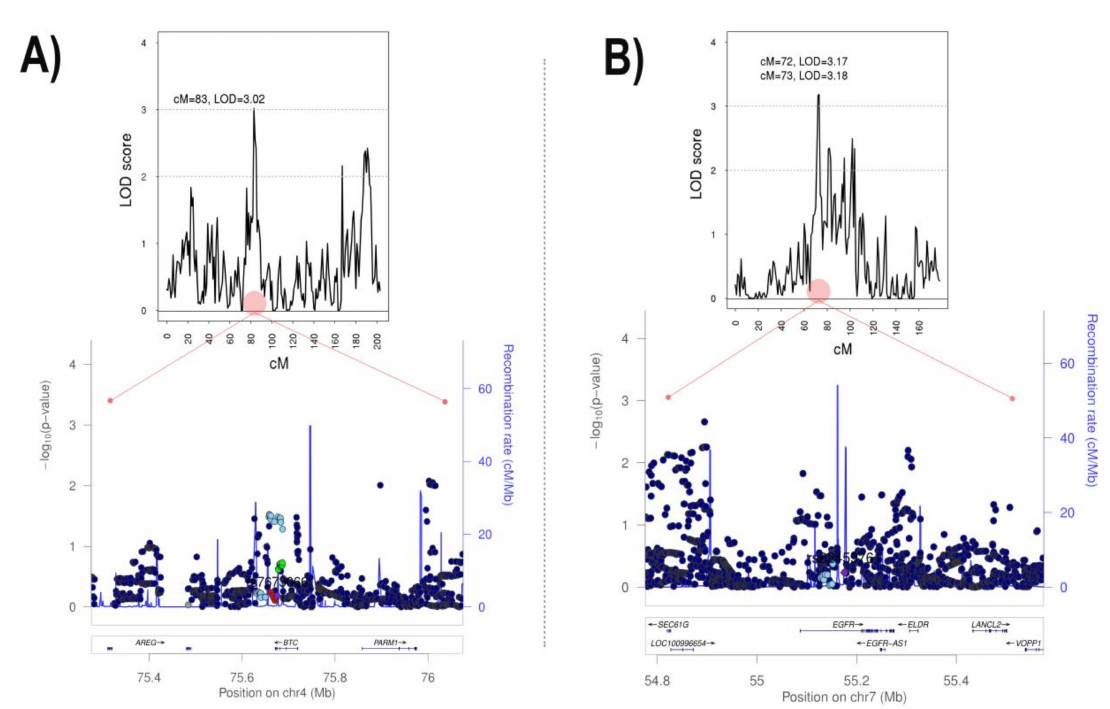
Figure 4. Significant linkage regions on chromosomes 4 ( A ) and 7 ( B ) and regional plots showing association analyses on the region under the maximum LOD